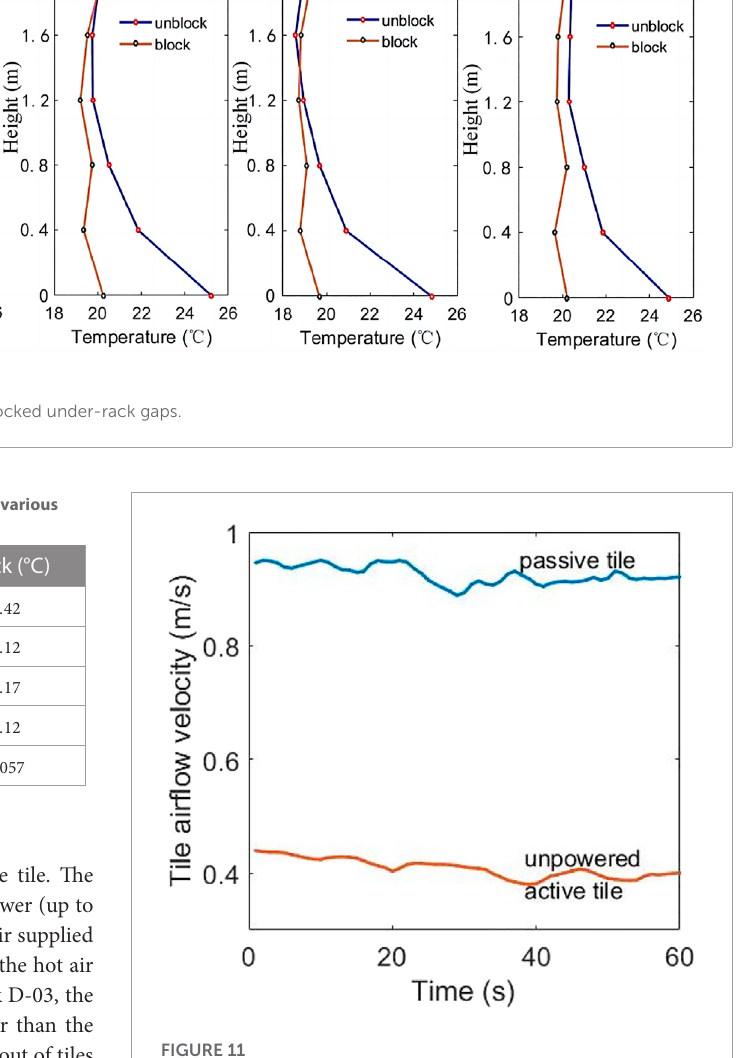
FIGURE 11 Tile airflow velocity for passive and unpowered active